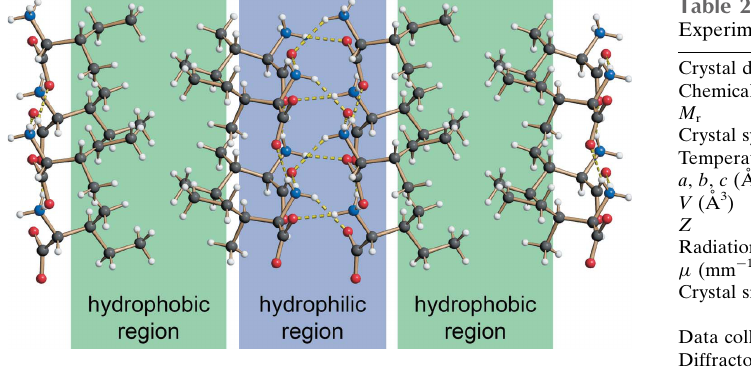
Figure 3 Hydrophilic and hydrophobic layers in the crystal structure of isoleucin (DAILEU01: Varughese & Srinivasan,